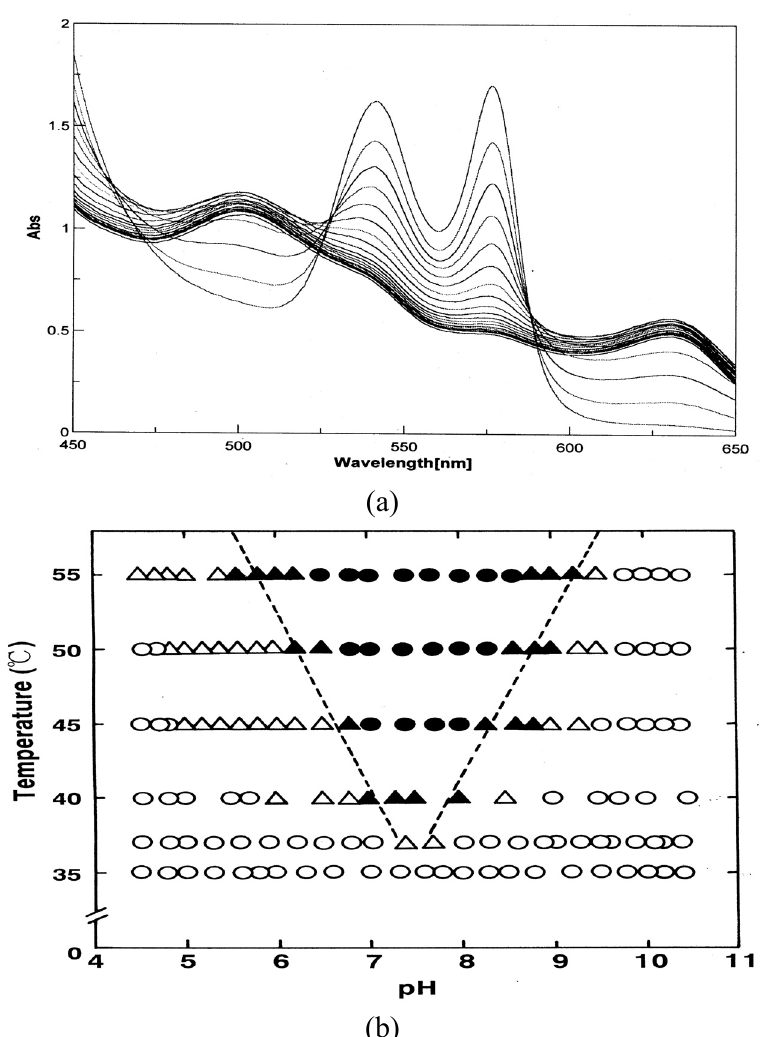
Figure 5. Hemichrome formation associated with human HbO autoxidation, redrawn from 2 Sugawara et al . [20]. ( a ) Spectral changes over time for hemichrome formation associated with human HbO autoxidation in which the reaction was monitored in 0.1 M MES buffer 2 (pH 5.0) at 37 °C and scanning interval = 15 min; ( b ) pH-temperature diagram for hemichrome formation of HbO . ● —hemichrome formation noticeable at the initial stage 2 during the course of autoxidation; ▲ —at the intermediate stage; △ —at the final stage; ○ —autoxidation reaction proceeded with no hemichrome formation during the entire